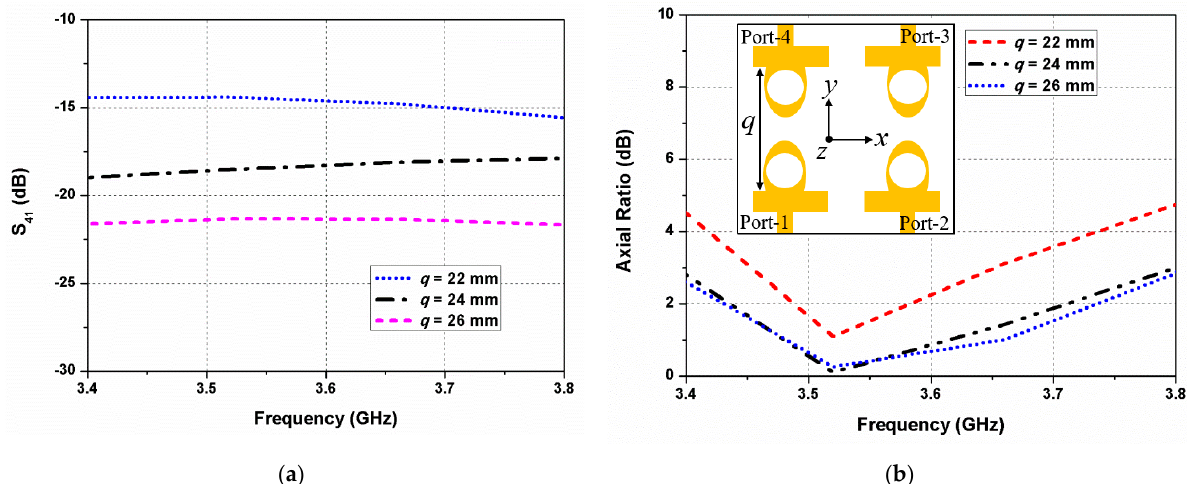
Figure 6. Effect of the vertical antenna spacing ( q ) on ( a ) S 21 and ( b ) axial ratio.